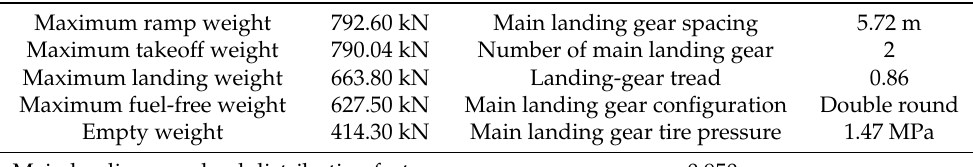
Table 2. B737-800 model calculation reference data.